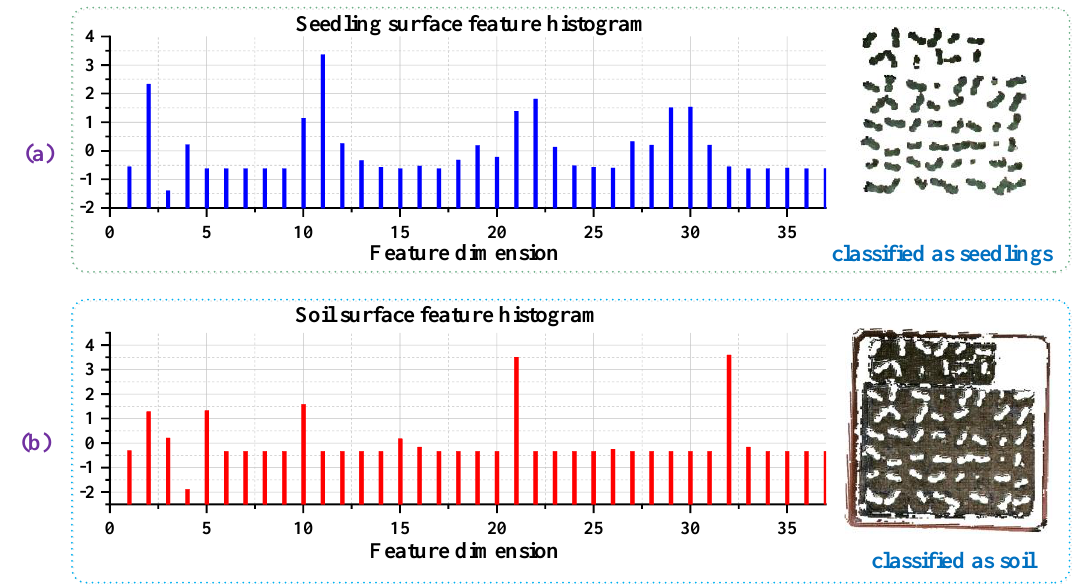
Figure 5. Surface feature histogram of ( a ) one point of cucumber seedlings and ( b ) one point of soil in 37-dim characteristic using 𝑟 𝑁 = 3.5 mm and 𝑟 𝐻 = 11.5 mm; 37-dim feature values were normalized, whose mean was zero and variance was one. Table 2. Optimal parameter pair for the removal of natural background in different vegetable seedlings.